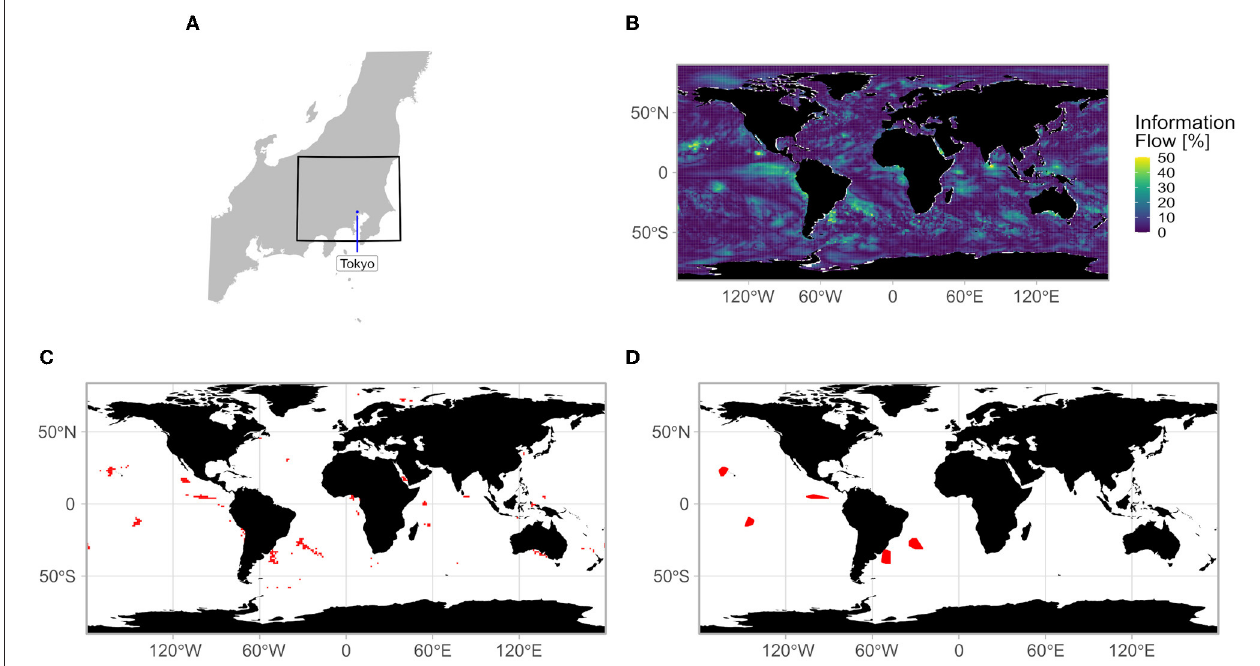
FIGURE 2 | (A) Location of the Kant¯o region (black box) in Japan. (B) Example of normalized information flow calculation, (C) grid points complying with the selection criterion (NIF ≥ 30%) for the global region, and (D) areas complying with the selection criteria (NIF ≥ 30%, surface area ≥ 300,000 km 2 ) for the global region.